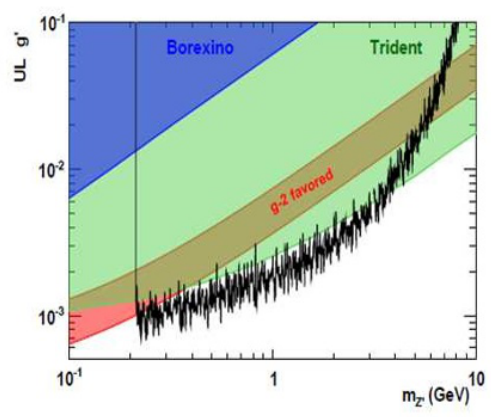
Figure 3. The 90% upper limit of the gauge coupling g ′ as a function of the Z ′ mass from B A B AR [10], together with the constraints coming from the production of µ + µ − pairs in ν µ scattering